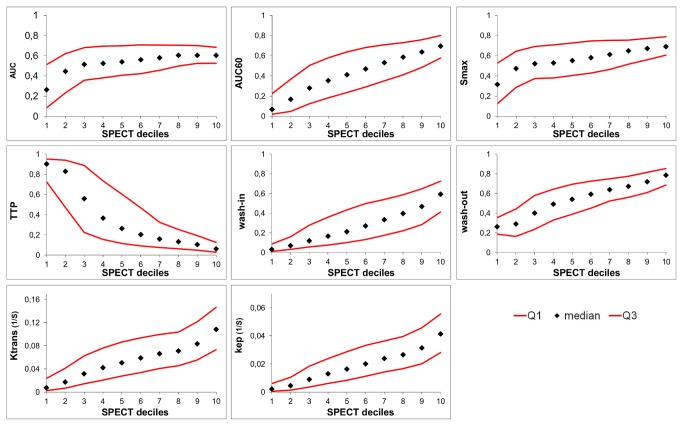
SPECT decile groups with corresponding median DCE-MRI parameter values.The median, Q1, and Q3 DCE-MRI parameter values for the different SPECT decile bins for one tumor. AUC, area under the whole curve; AUC60, area under the curve for the first 60 s; Smax, maximum enhancement; TTP, time to peak; wash-in, slope between the 10% point and the 90% point on the enhancement curve [19]; wash-out, slope between the point of maximum enhancement and the last time point [20]; Ktrans (s-1) capillary transfer constant [20]; kep (s-1), contrast exchange rate [20]. Semi-quantitative parameters were normalized.